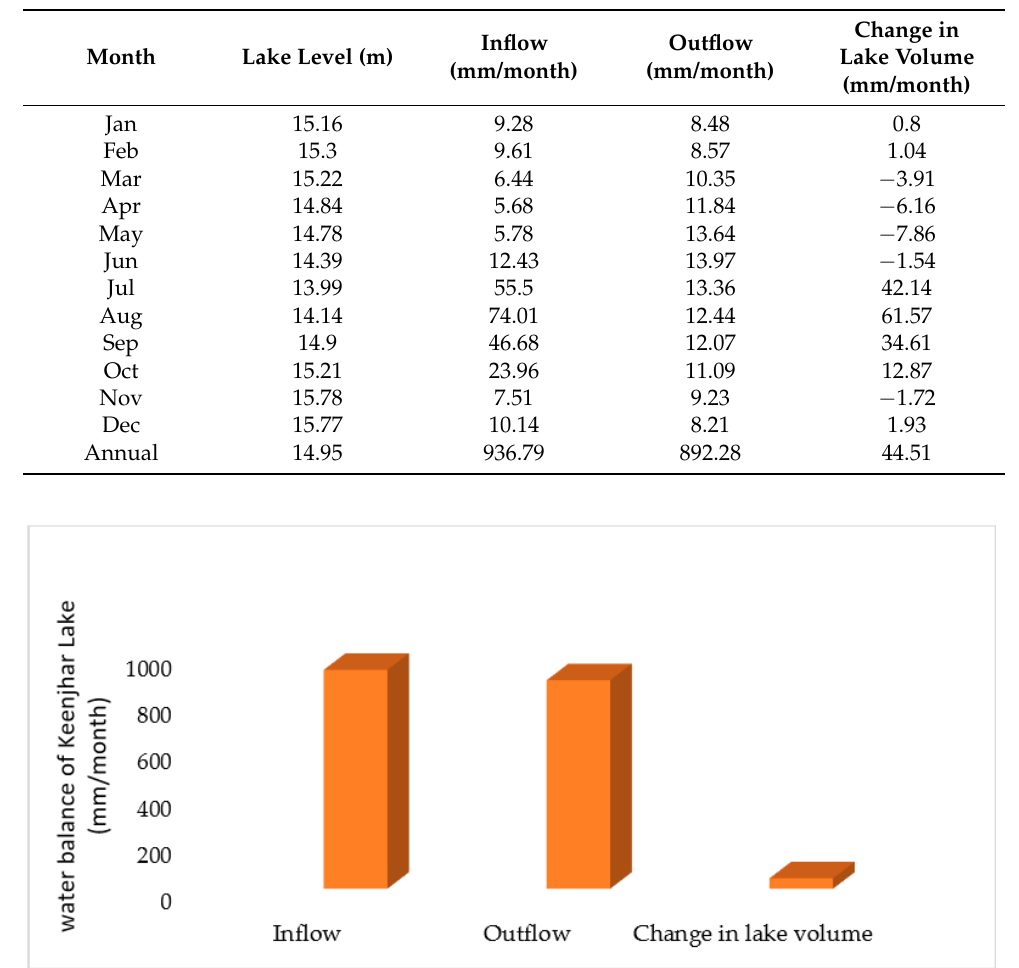
Figure 8. Annual water balance of Keenjhar Lake.